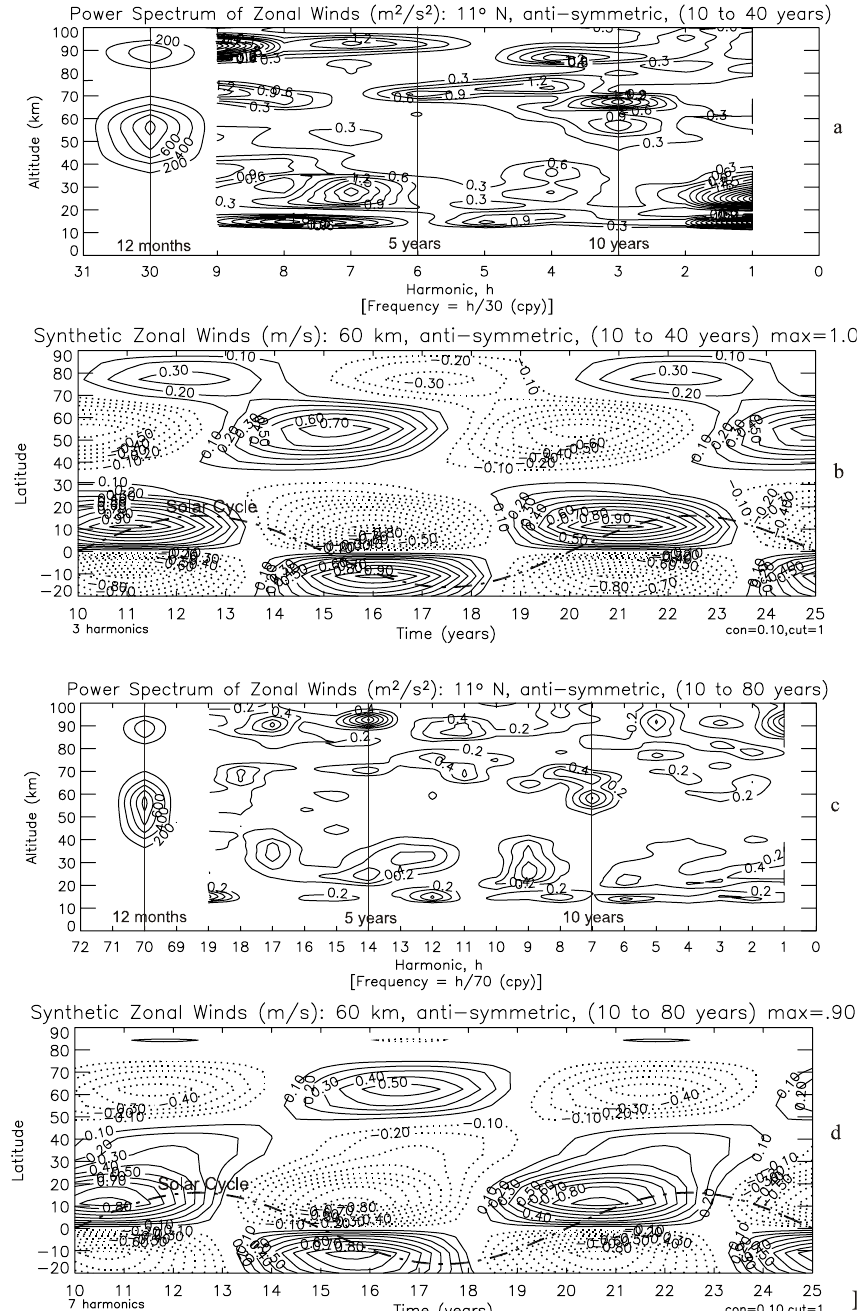
Fig. 11. (a) Spectrum of the anti-symmetric zonal wind component for the time span from 10 to 40 years, covering the harmonic range 0 <h< 9 to reveal the 5- and 10-year SC signatures. At h =3, a relatively sharp but weak feature appears at altitudes around 60km in the mesosphere, which reflects the small SC heating applied in the model. Also shown is the spectrum around the dominant, and much larger, anti-symmetric 12-month oscillation at h =30 (note the different contour intervals). (b) Synthesis of the anti-symmetric 10-year SC component at h =3 shows small wind velocities at 60km varying with latitude. These winds interact apparently in a non-linear way with the strong anti-symmetric 12-month oscillation and thus produce the SC modulated symmetric EAO shown in Fig. 7. (c) Similar to (a) but for the model run from 10 to 80 years, showing again the sharp SC signature at around 60km. (d) The synthesized winds reveal a pattern very similar to that in (b), which reflects the persistent SC forcing applied in the